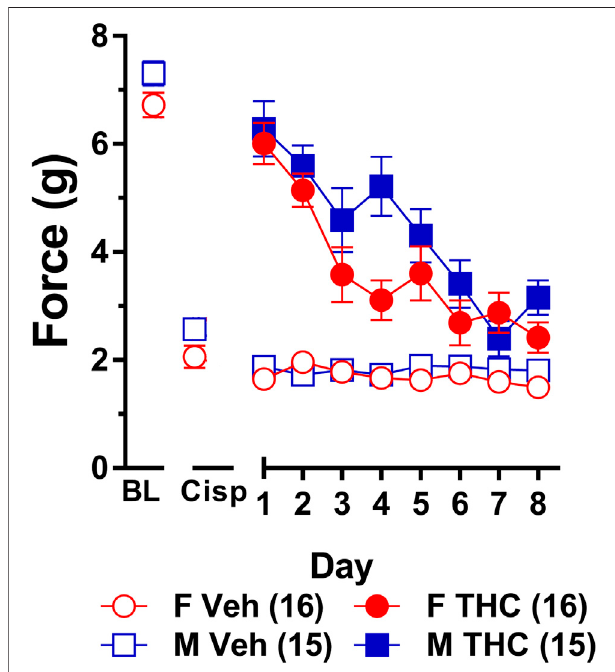
FIGURE 4 | Development of tolerance to the anti-allodynic effects of 10 mg/kg of Δ 9 -THC in male and female wild-type mice. Tolerance to theanti- allodynic effects of vehicle (un fi lled) and 10 mg/kg ( fi lled) Δ 9 -THC was determined in both male (squares) and female (circles) wild-type (WT) mice using the von Frey. Mice were fi rst assessed for the amount of force (in grams) required to elicit a paw withdrawal response 60 min following treatment with vehicle and 60 min later following treatment with 10 mg/kg Δ 9 -THC. BL represents the pre-cisplatin baseline and CISP the post- cisplatin baseline. Error bars represent the mean ± SEM. Each mouse was testedintriplicateandthosevaluesaveragedtodetermineasinglevalueforeach mouse for each dose tested on each day of testing. Data were analyzed using separate two-way ANOVAs with Bonferroni post-hoc tests. Sample sizes for each group (shown in parentheses) include 15 male and 16 female WT mice.